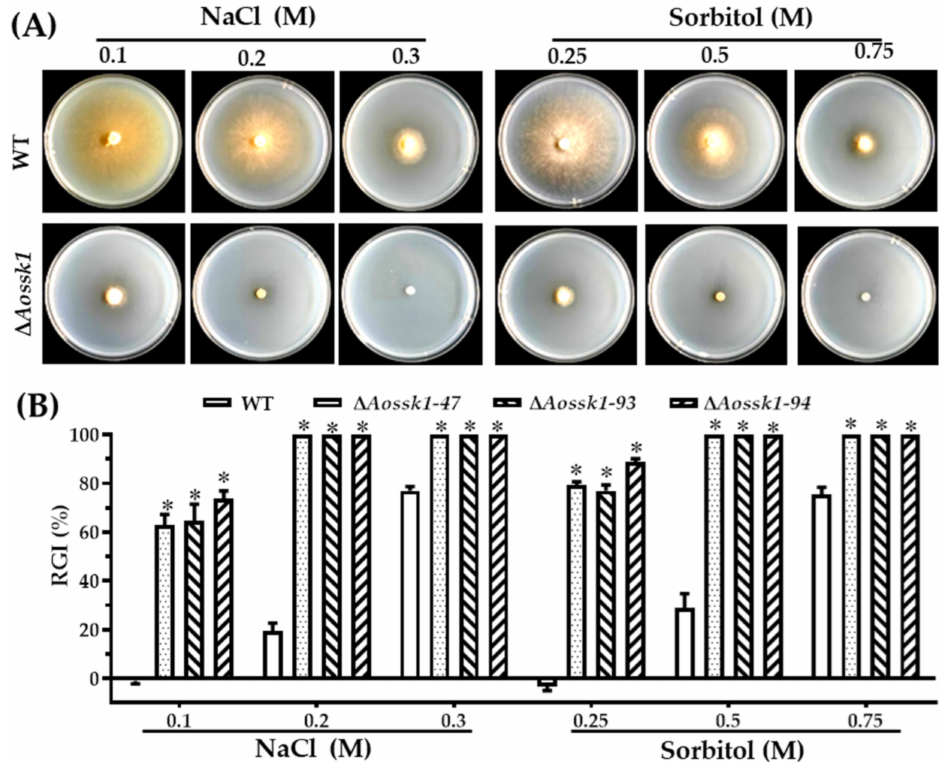
Figure 5. Comparison of osmotic stress responses between WT and ∆ Aossk1 mutant strains. ( A ) Colo- nial morphology of fungal strains under osmotic stress. ( B ) Relative growth inhibition (RGI) of fungal colonies after being grown for 6 days at 28 ◦ C on TG plates supplemented with different concentrations of NaCl and sorbitol. An asterisk indicates a significant difference between ∆ Aossk1 mutant and the WT strain (Tukey’s HSD, p <